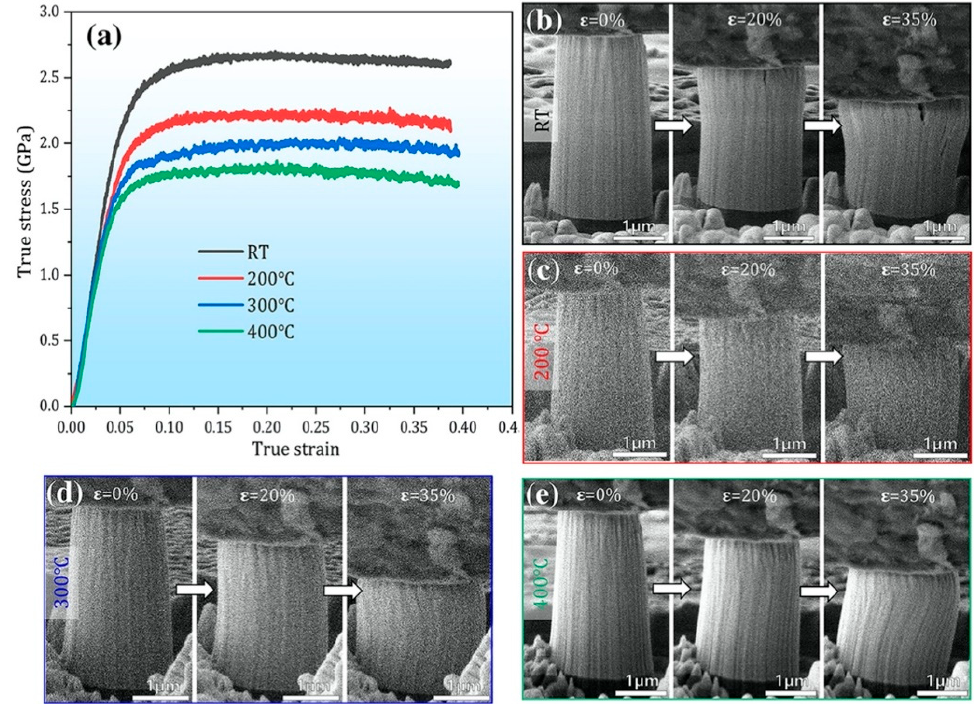
Figure 10. ( a ) The true stress–strain curves of as-deposited Ni(75 at.%)-SiOC nanocomposite at deformation temperatures of RT, 200 °C, 300 °C, and 400 °C [53]. ( b – e ) SEM snapshots of the micropillars at di ff erent strains.